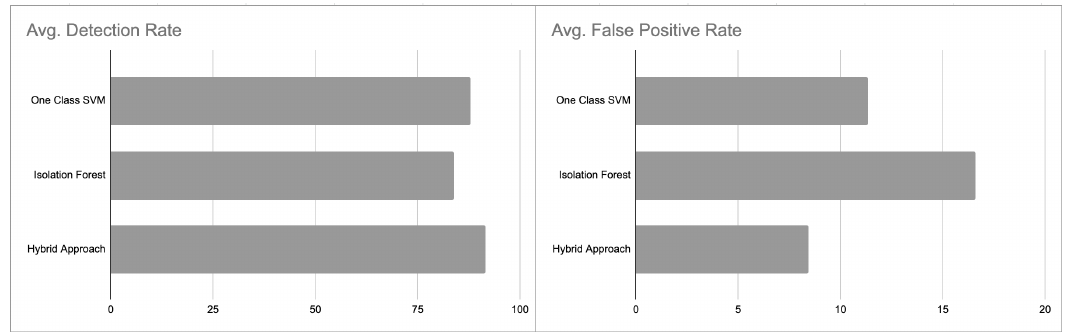
Figure 6. Comparison of Avg. FPR and Avg. detection